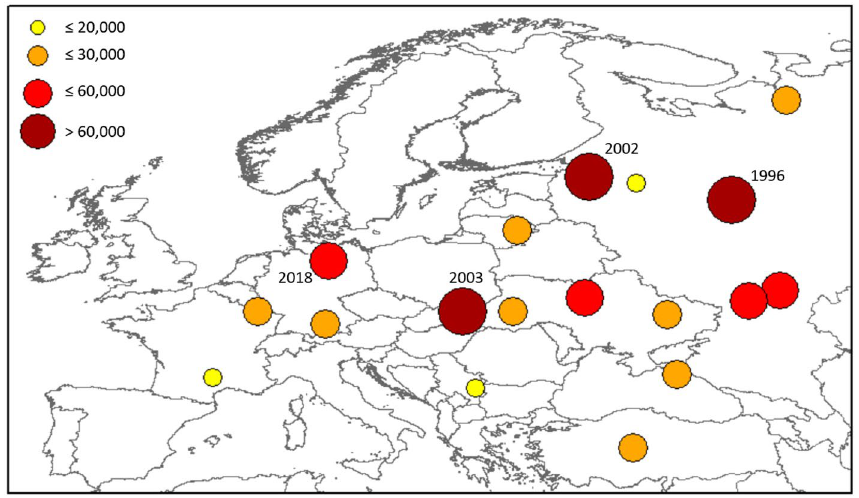
Figure 3. Location of the centroids of the major droughts in Europe according to the clustering algorithm. The circles are proportional to the size of the event (in number of